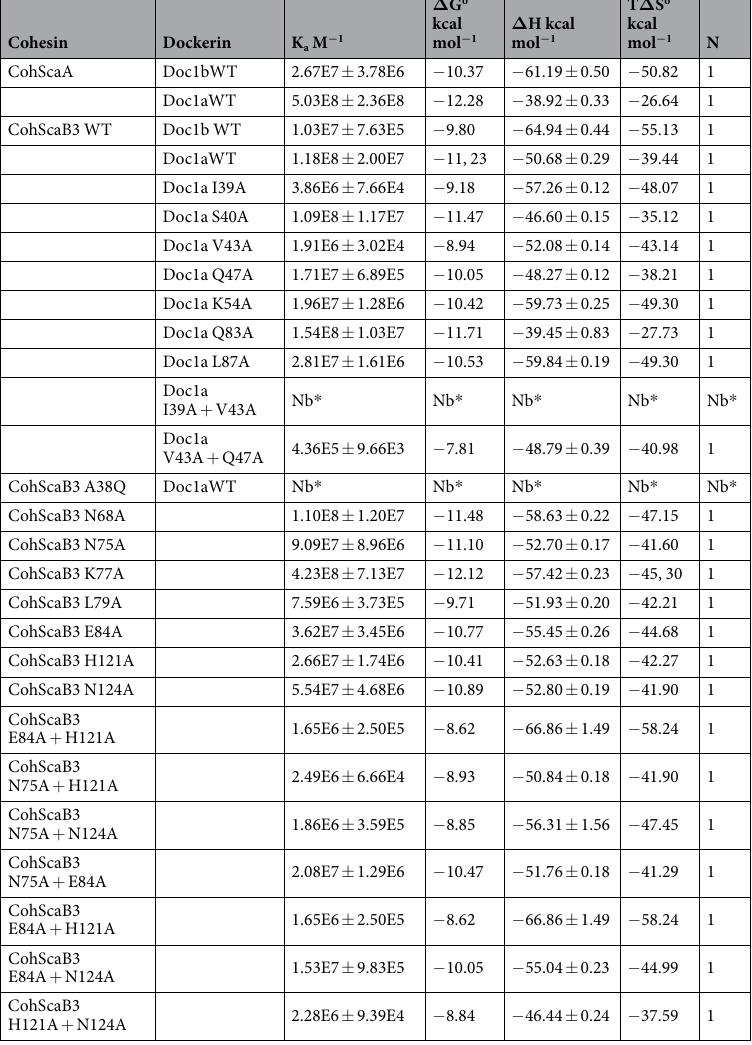
Table 2. Thermodynamics of the several interactions tested by ITC. All Thermodynamic parameters were determined at 308 K. * Nb - No